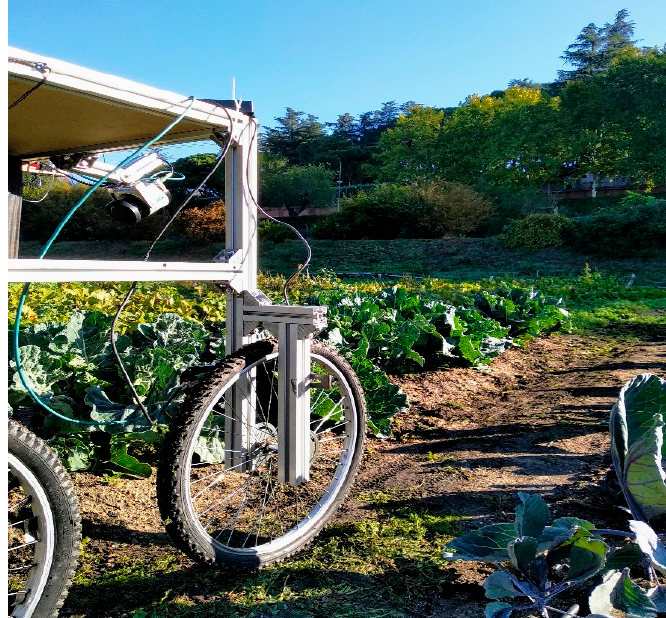
Figure 1. Robotic prototype developed by the SUREVEG team.